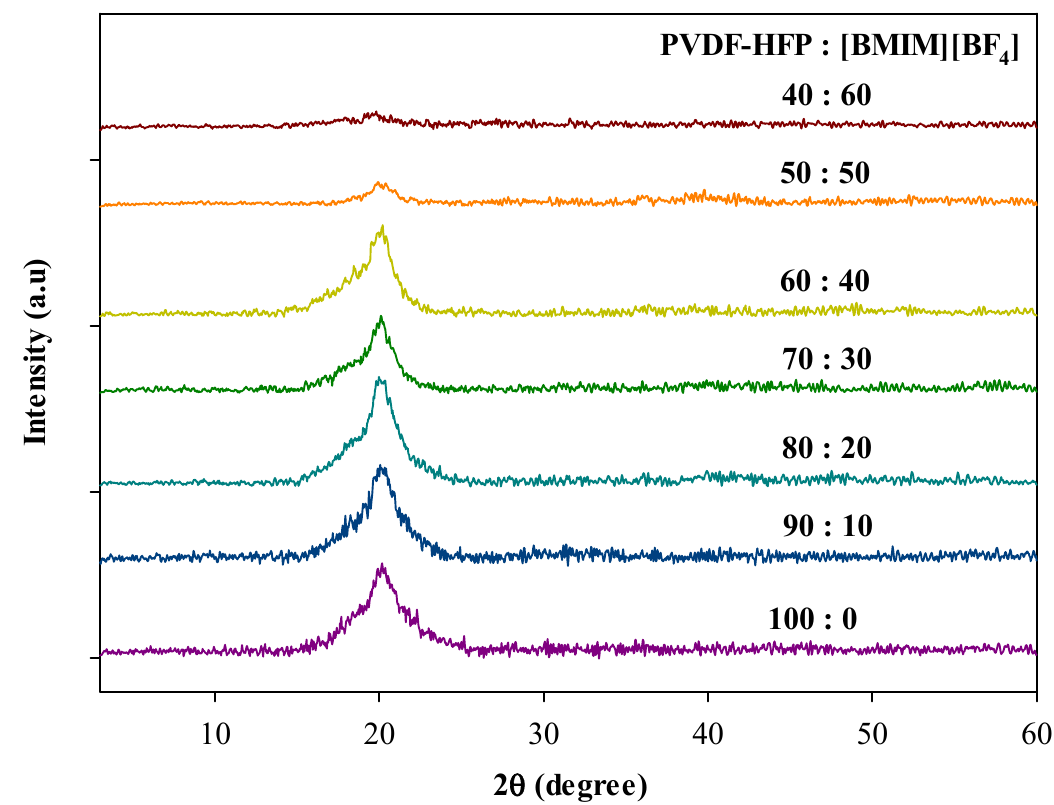
Figure 9. Diffractogram of pure PVDF-HFP and different percentage ratio of PVDF-HFP to [BMIM][BF 4 ].